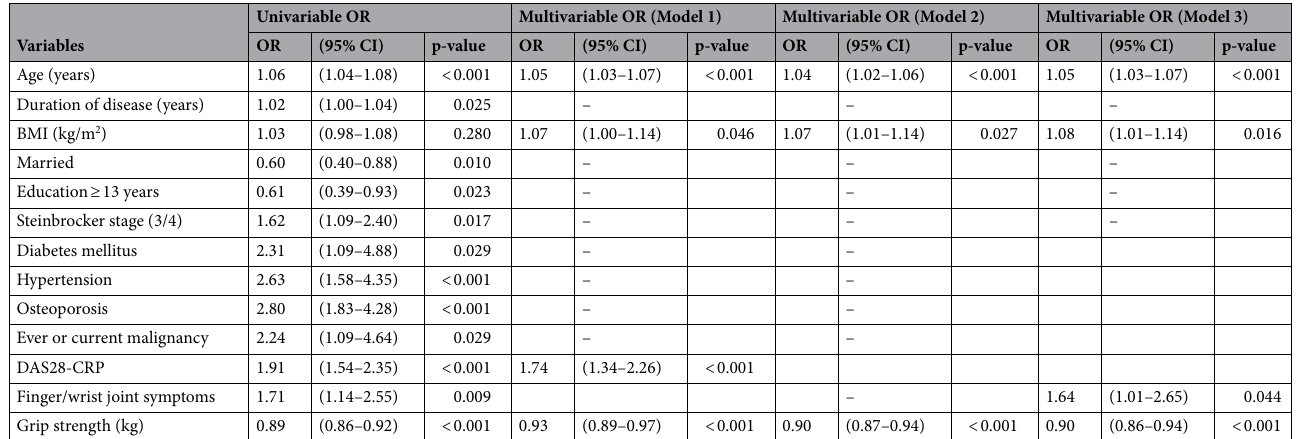
Table 3. Odds ratios for frailty by logistic regression analyses. Frailty, The Kihon Checklist (KCL) ≥ 8 points. OR odds ratio, CI confidence interval, BMI body mass index, DAS28-CRP 28-joint count Disease Activity Score using C-reactive